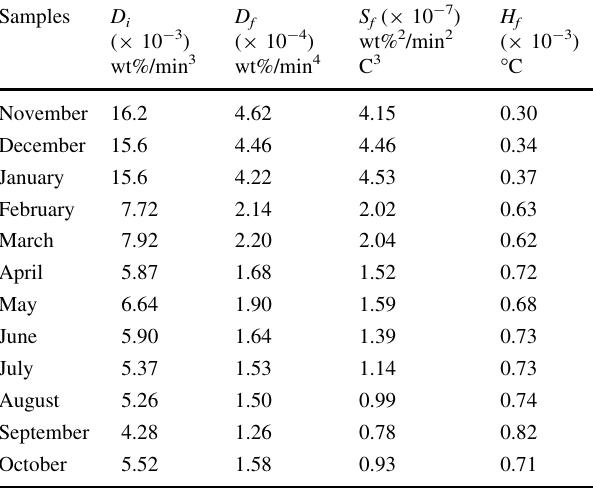
Table 2 Monthly variation of ignition, burnout index and perfor- mance indices Samples